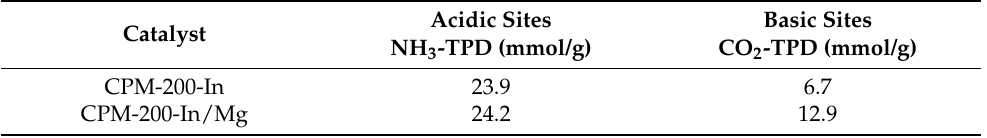
Table 2. Number of acidic and basic sites in the